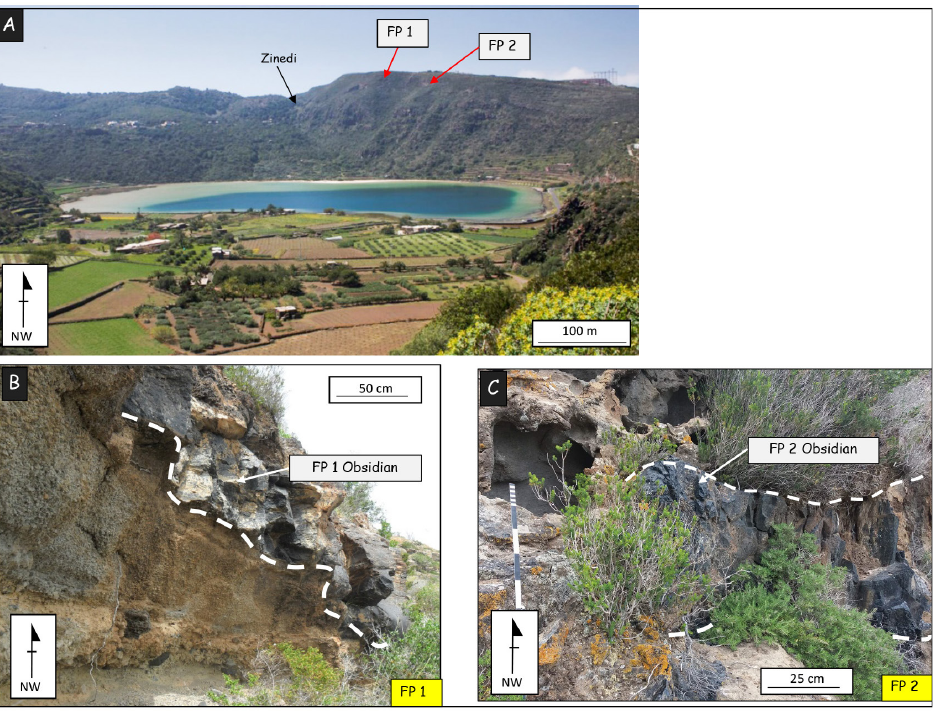
Figure 2: Field photographs showing the two Fossa della Pernice sites (FP 1, FP 2) located in the scarp above Lago di Venere ( Venus’ Lake ).